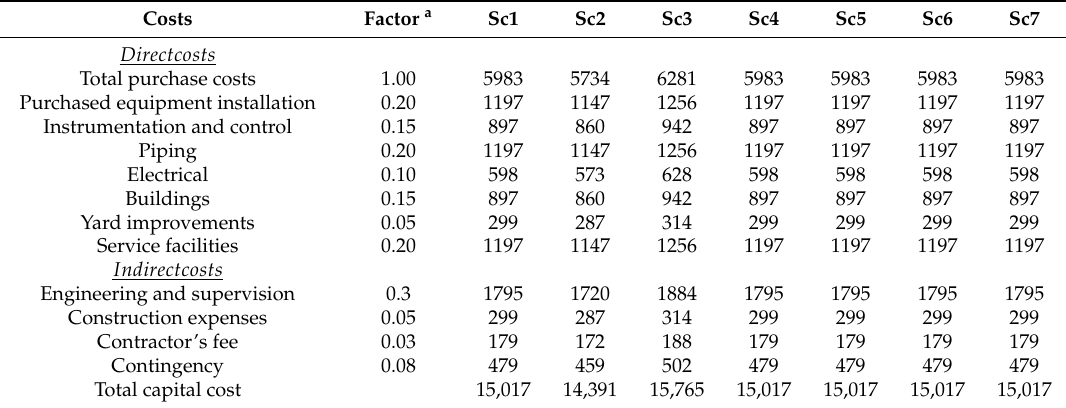
Table 7. Total capital (fixed capital) cost estimation (in k € ) in each of the studied scenarios (Sc).